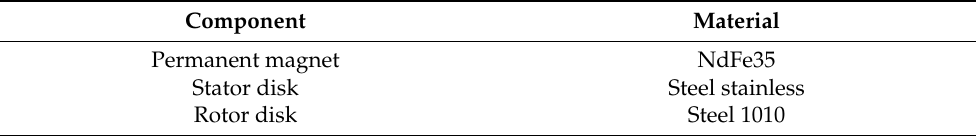
Table 2. Material selection of electromagnetic damper components.